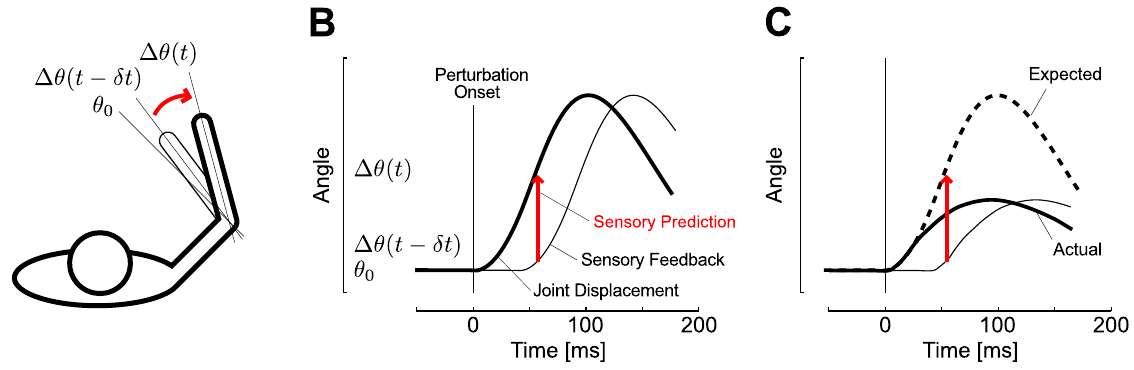
Figure 1. Correction of state estimation following a perturbation. A: Overhead sketch of a perturbation evoked displacement relative to the prescribed joint location ( h 0 ). The initial change in joint angle following a perturbation is sensed after some delay (thin trace, Dh (t 2 d t) ). A correction of the actual change in joint angle (thick trace, Dh (t) ) involves a prediction based on the available sensory data combined with an internal model of the perturbation (red arrow). B: Schematic representation of the sensory prediction on the joint displacement plotted as a function of time (numbers are for illustration). The sensory prediction (red arrow) estimates the present state of the limb (thick trace) based on delayed sensory feedback (thin trace) and internal assumptions about the perturbation profile. C: Illustration of overestimation resulting from updating the current state estimate based on an expected movement profile (dashed trace) that follows the same initial displacement as the actual one but diverges during the time interval corresponding to the feedback delay (solid